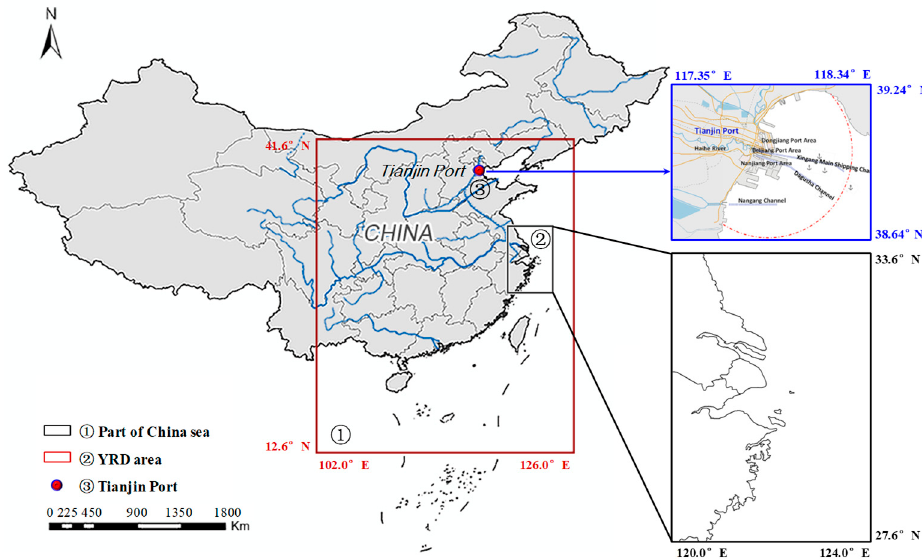
Figure 4. Sketch map of the study area.